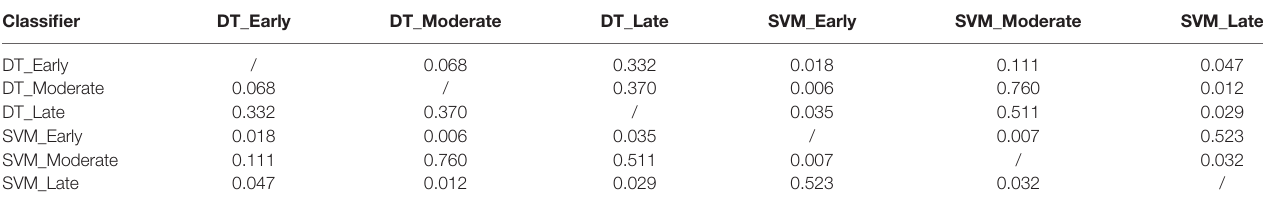
The symbol ("/") represents null.